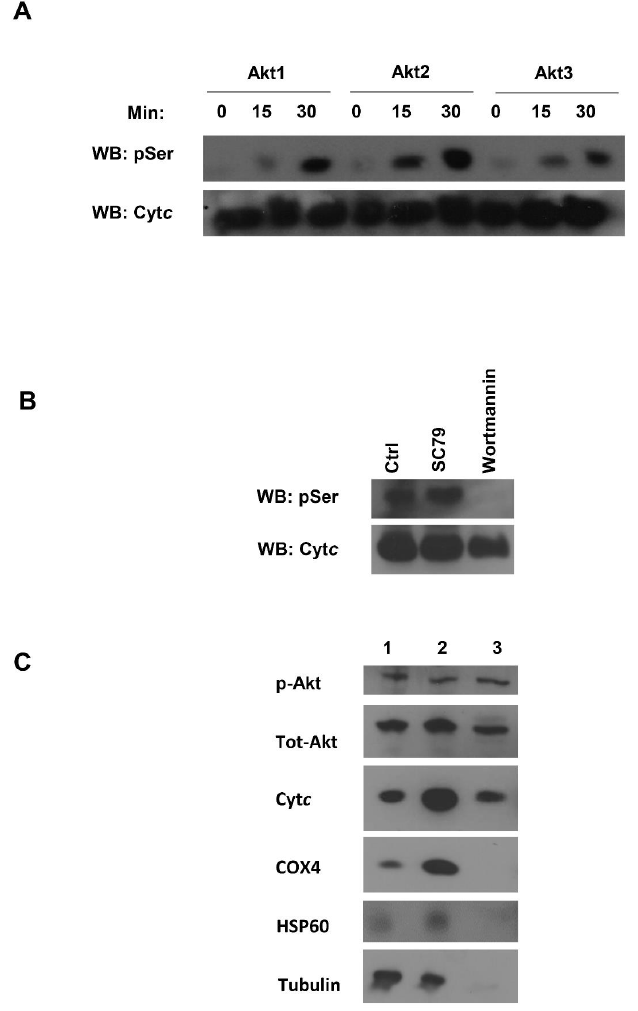
Figure 6. ( A ) In vitro Akt kinase assay showing a time-dependent increase in serine phosphorylation at 0, 15, and 30 min. BSA was used as a negative control (not shown). ( B ) The purified pig brain Cyt c, following SC79 (Akt activator), wortmannin (Akt inhibitor), and control (DMSO) treatments, was assessed for S47 phosphorylation. ( C ) Pig brain mitochondria fractionation. Lane1, pig brain tissue lysate; lane 2, crude mitochondria; lane 3, mitochondrial intermembrane space (IMS) fraction. COX4, HSP60, and tubulin were used as an inner mitochondrial membrane (IMM), mitochondrial matrix, and cytosolic markers,